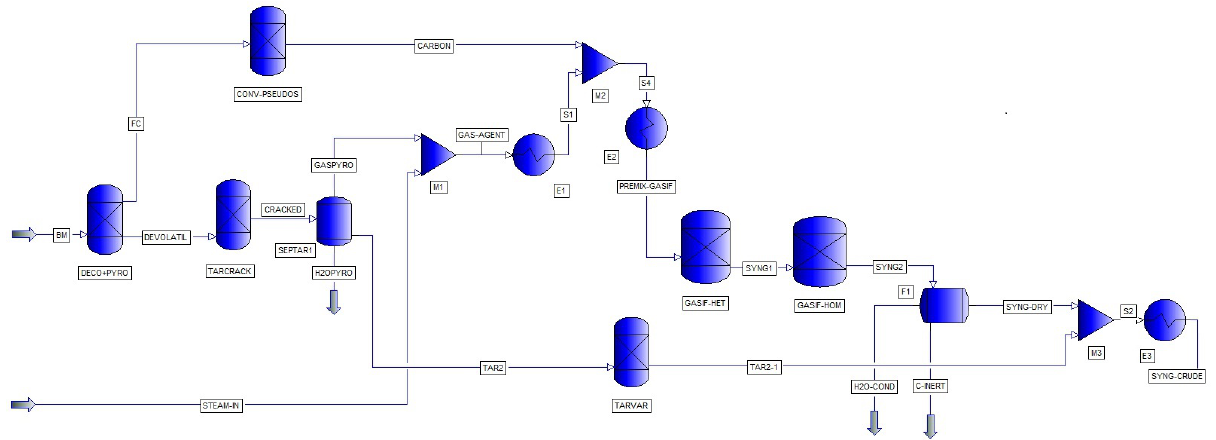
Figure A1. Flow diagram for the StoicM model in PRO/II.